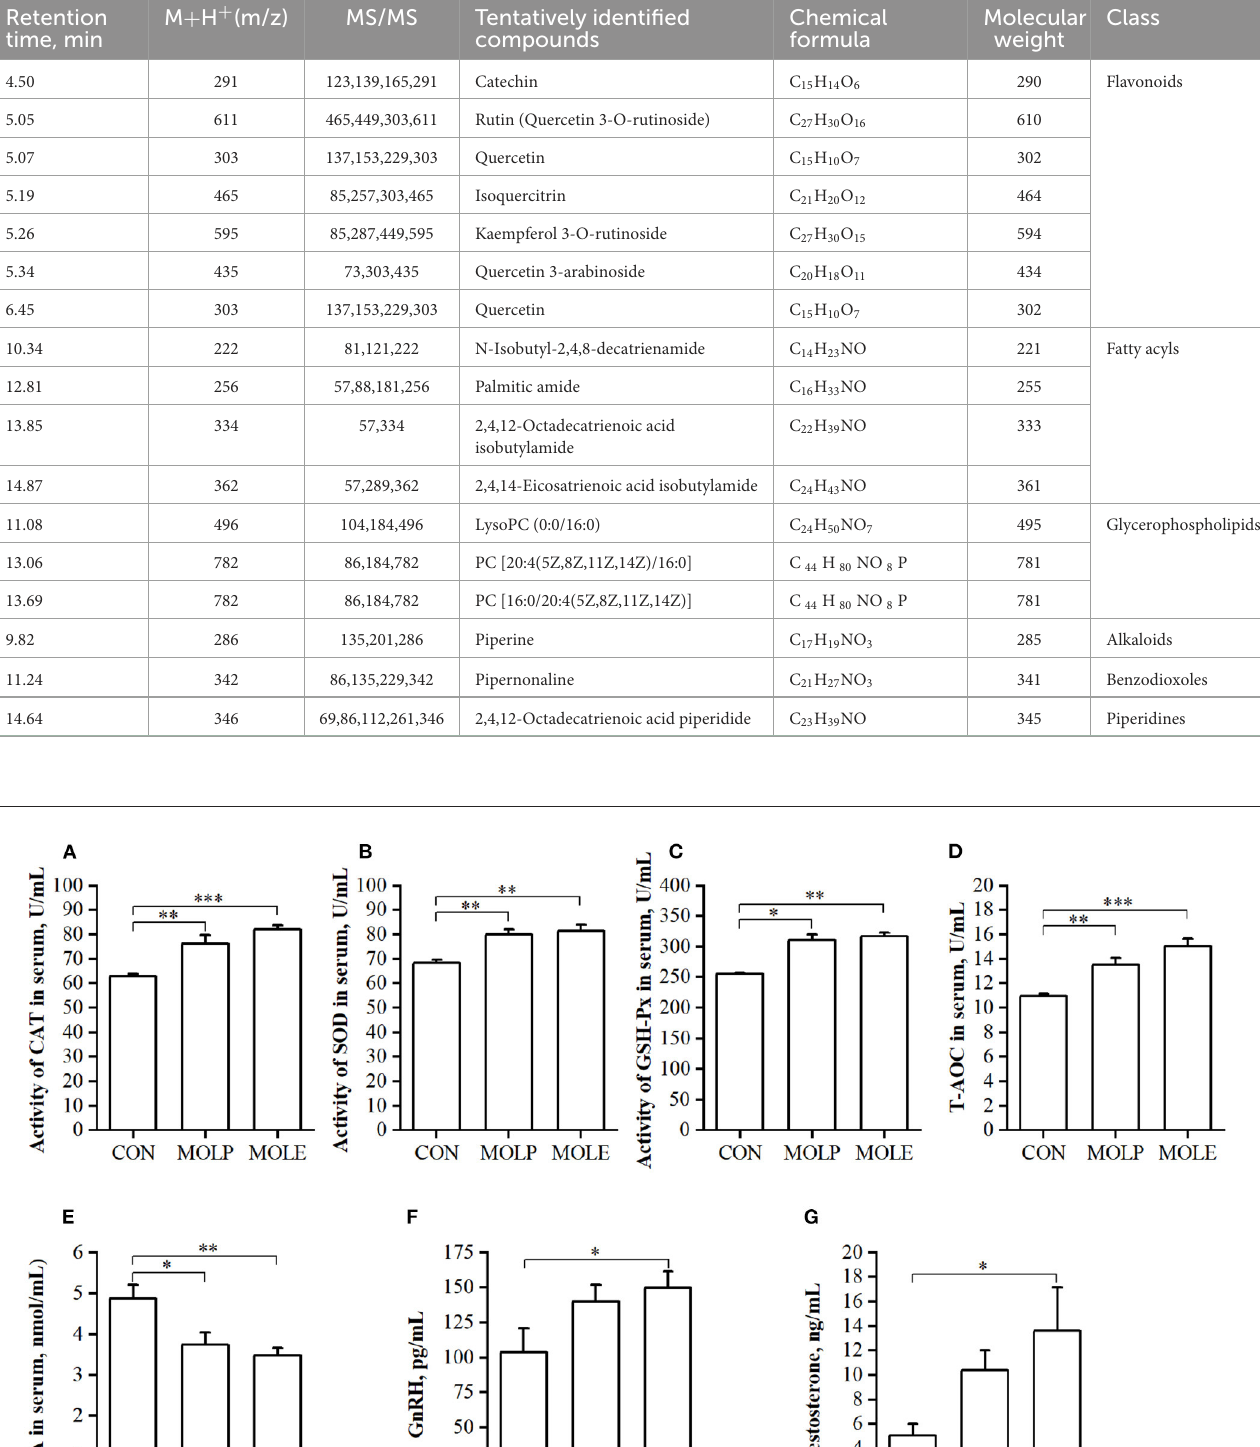
TABLE 1 Chemical composition of MOLE detected by LC-MS.